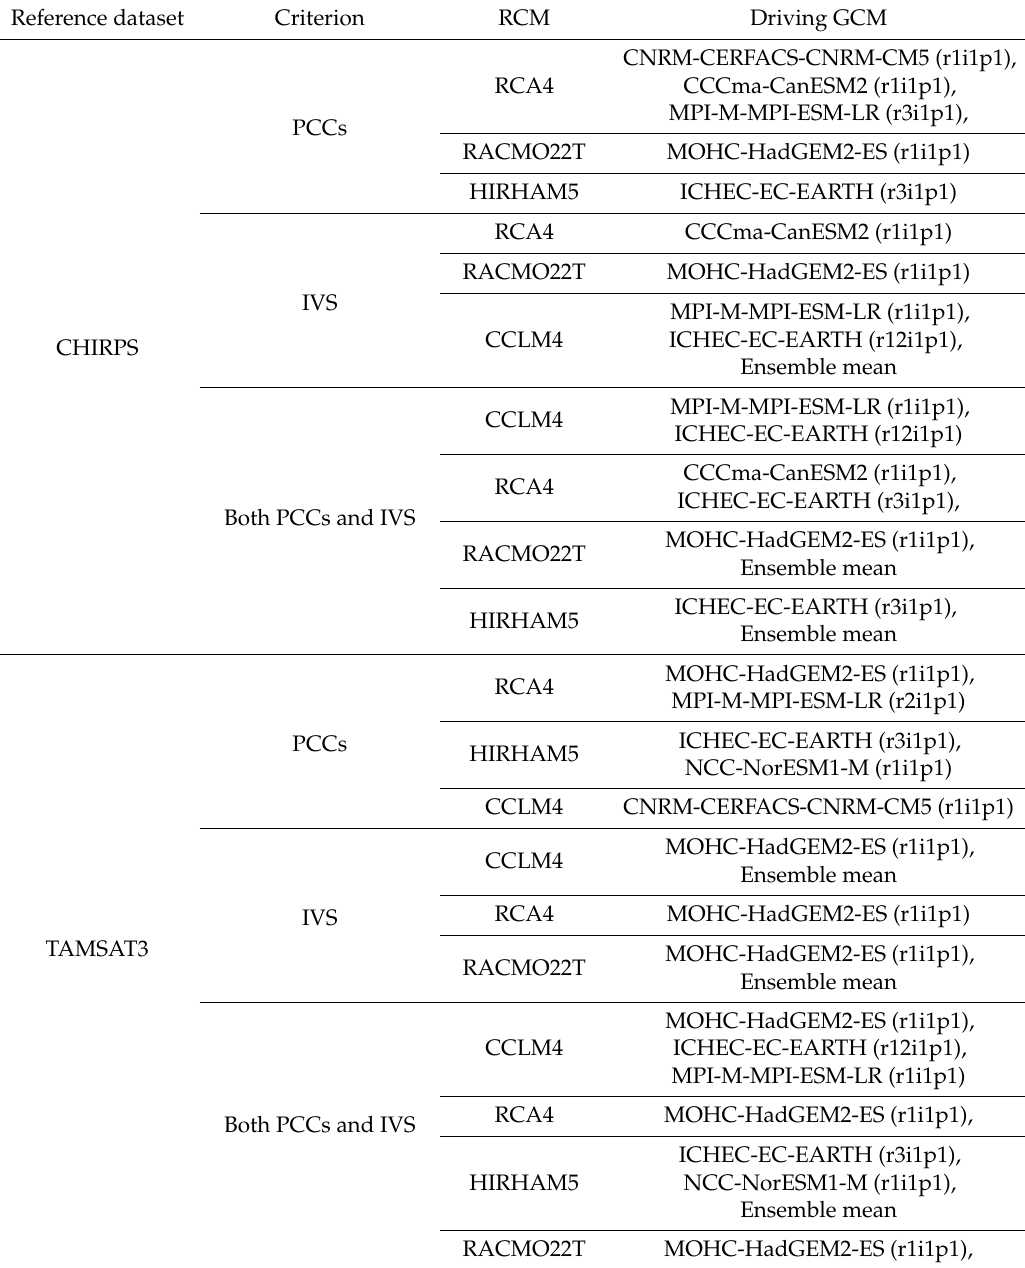
Table 4. As in Table 3 but for south West Africa